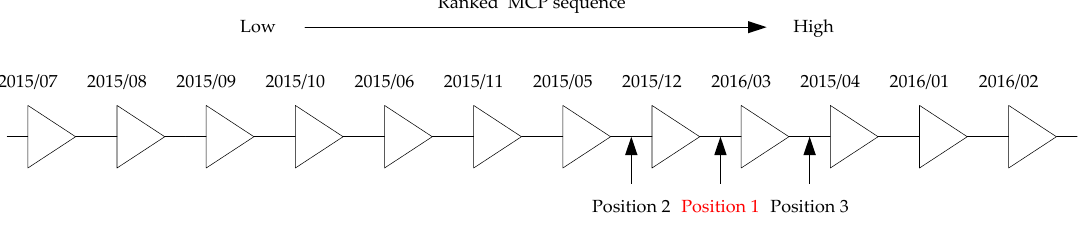
Figure 8. Different positions of April 2016 in the ranked market clearing price (MCP) sequence.